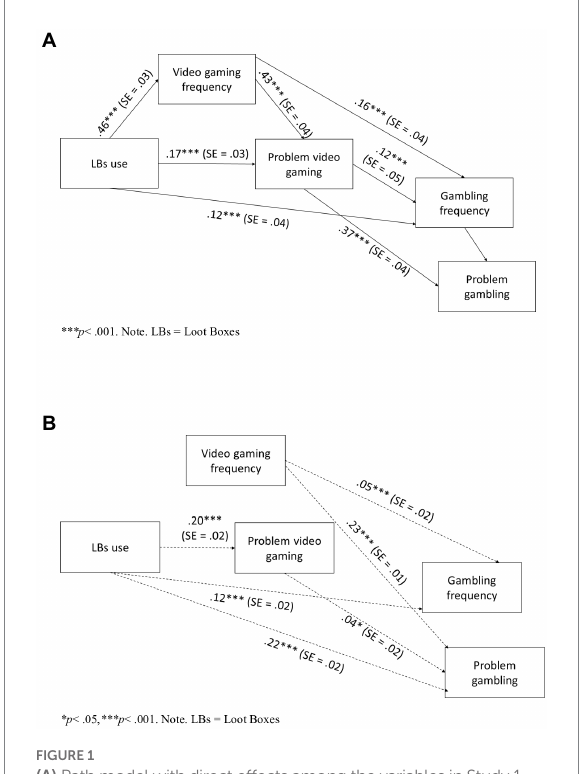
FIGURE 1 (A) Path model with direct effects among the variables in Study 1. (B) Path model with indirect effects among the variables in Study